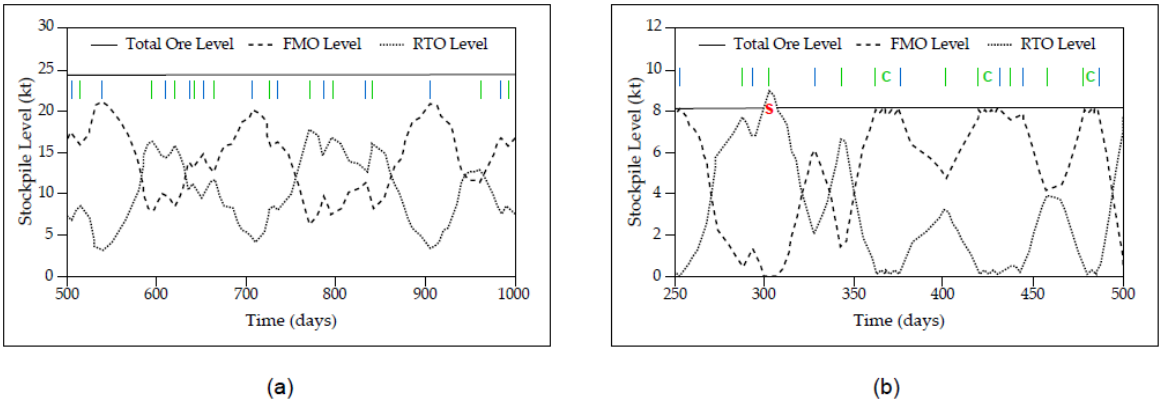
Figure 8. Representative graphical outputs from the DES framework, showing ( a ) stable plant operation with alternation between Modes A (green) and B (blue) over a period of 500 operating days (critical RTO level = 8100 t; target total ore level = 24,300 t); ( b ) system under stress with one mine surging event (red “S”) and three contingency modes (green “C”) triggered by inadequate FMO and RTO levels, respectively, over 250 operating days (critical RTO level = 2700 t; target total ore level = 8100 t).